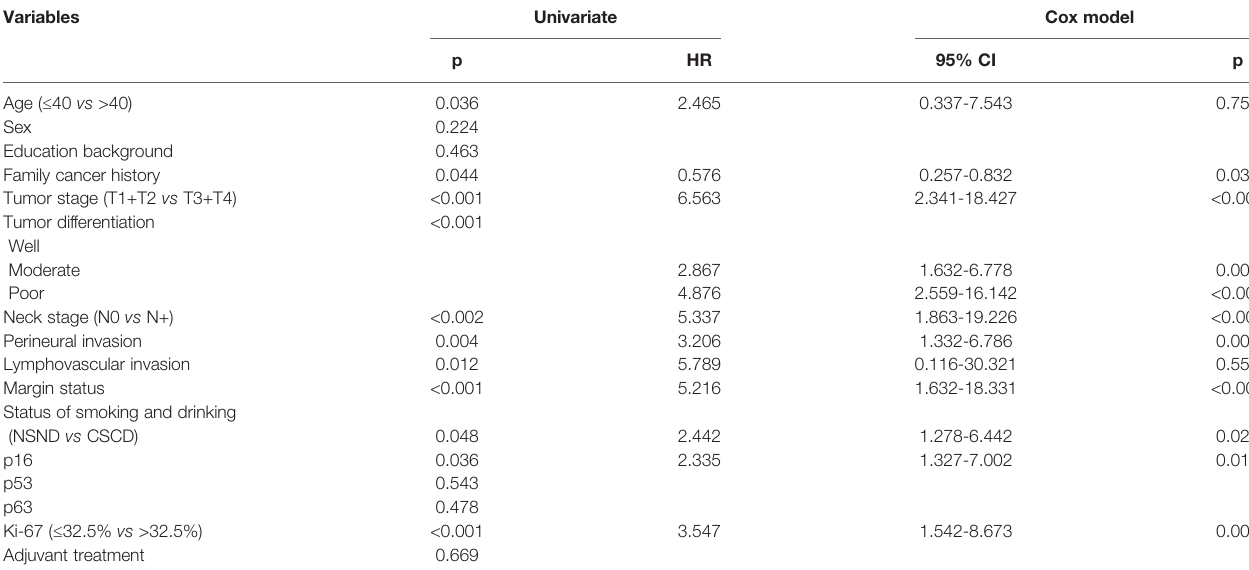
TABLE 2 | Univariate analysis and Cox model analysis of risk factors for locoregional recurrence in oral squamous cell